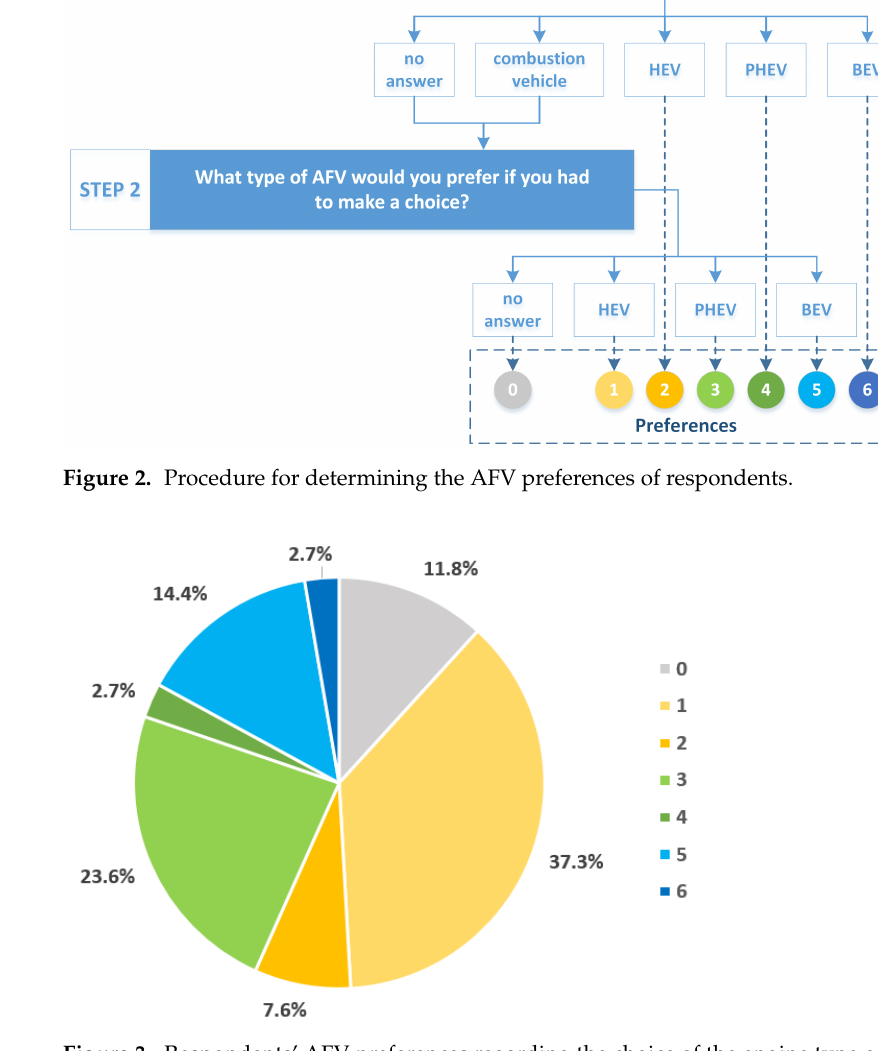
Figure 3. Respondents’ AFV preferences regarding the choice of the engine type on a scale of 0 to 6 (N =